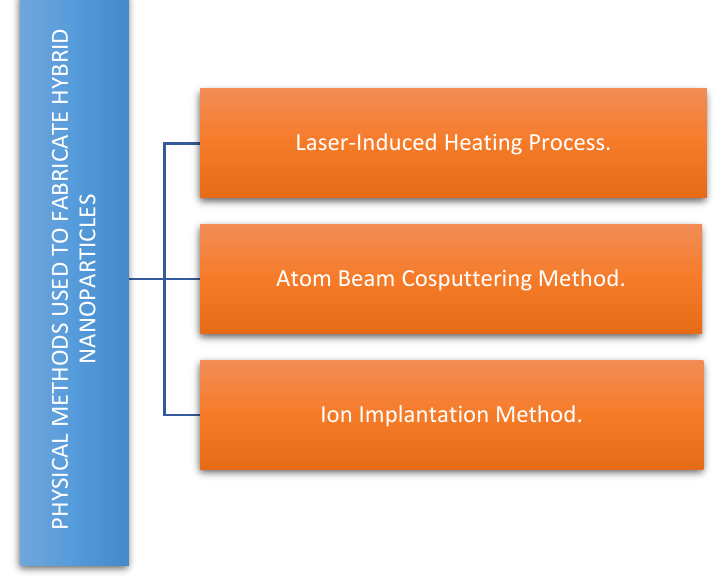
Figure 5. Main physical methods used to fabricate hybrid nanoparticles.